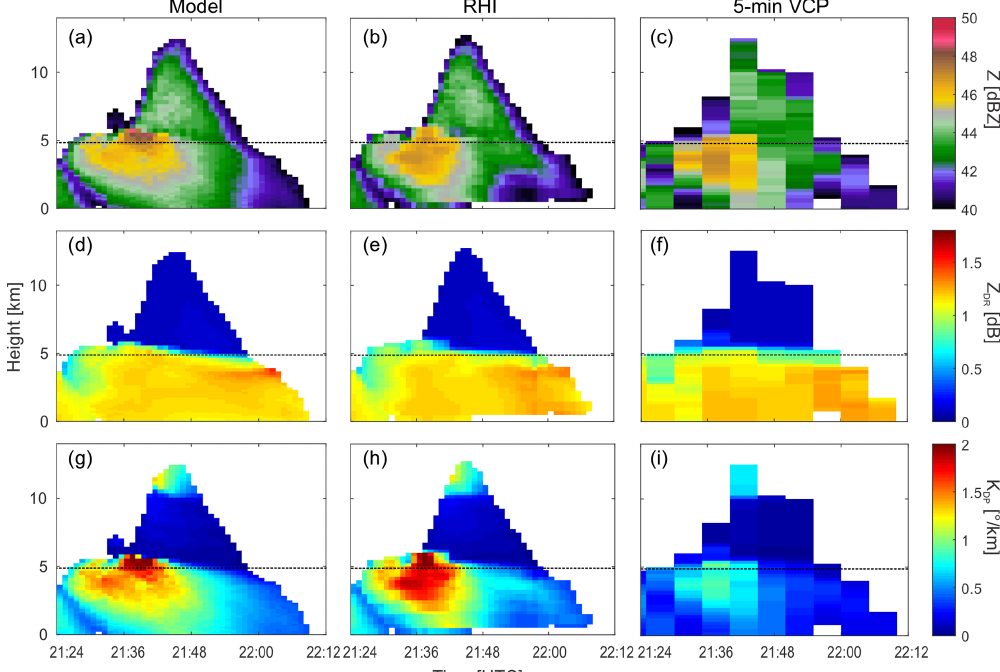
Figure 5. Time–height cross sections of C-band radar reflectivity (a–c) , Z DR (d–f) , and K DP (g–i) averaged for areas with reflectivity > 40dBZ for the selected convective cell for (a, d, g) the model simulation truth, (b, e, h) simulated RHI tracking strategy, and (c, f, i) sim- ulated 5min volume scan strategy. The cell in this figure is the same as that shown in the box in Fig. 4 and is from the CLN case. Note that the NEXRAD S-band frequency is assumed for the 5min VCP simulation, while C-band frequency is assumed for the model and RHI simulation. Therefore, the K DP values in this figure include the frequency dependency. The dashed line in each panel represents a 0 ◦ C isotherm of domain-averaged